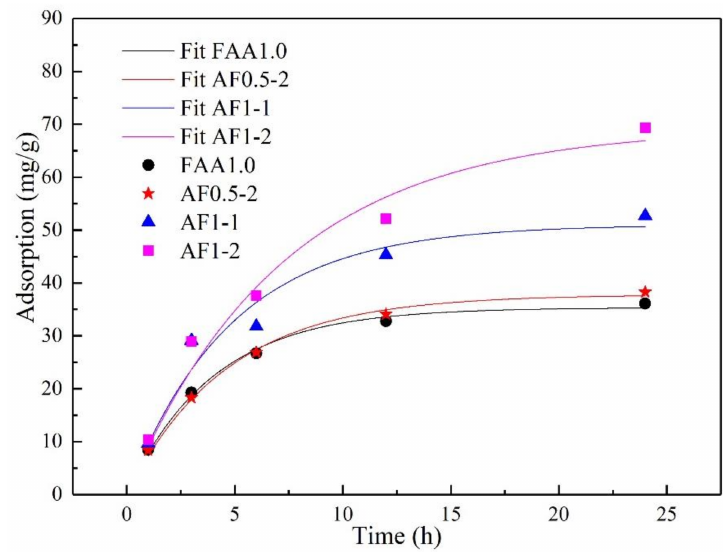
Figure 11. Pb 2+ adsorption capacity of FAA1.0, AF0.5-2, AF1-1, and